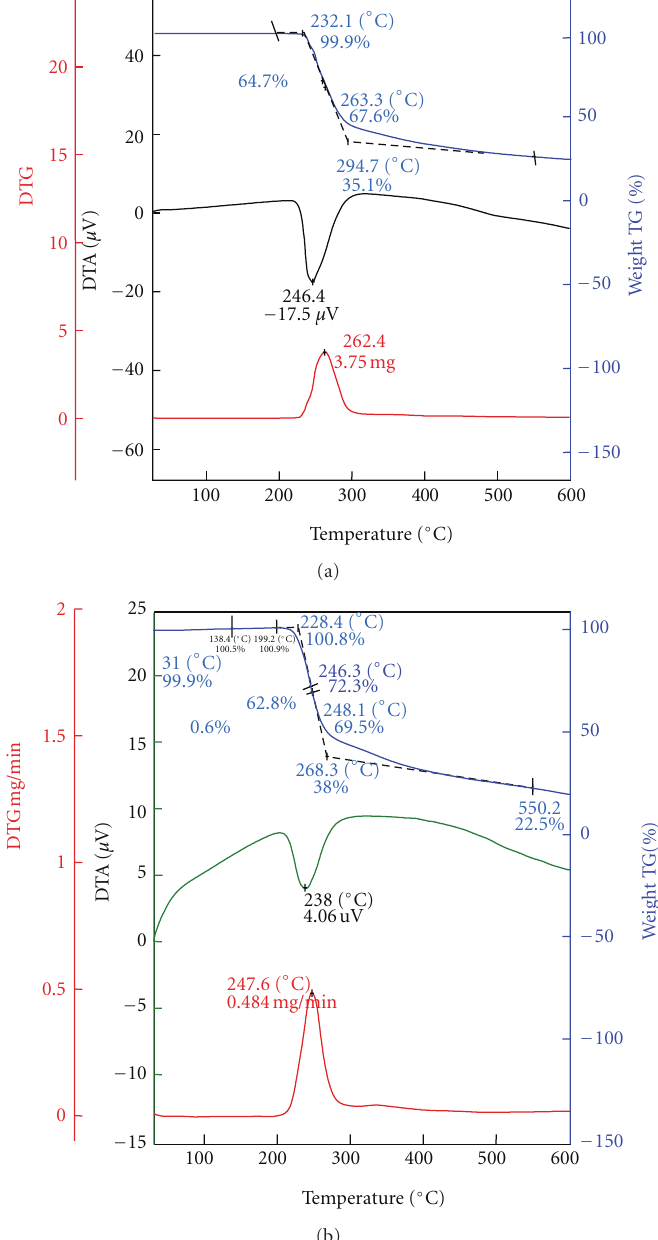
Figure 7: (a) TG/DTA for pure TGS. (b) TG/DTA for 1 mole % LiSO 4 -doped